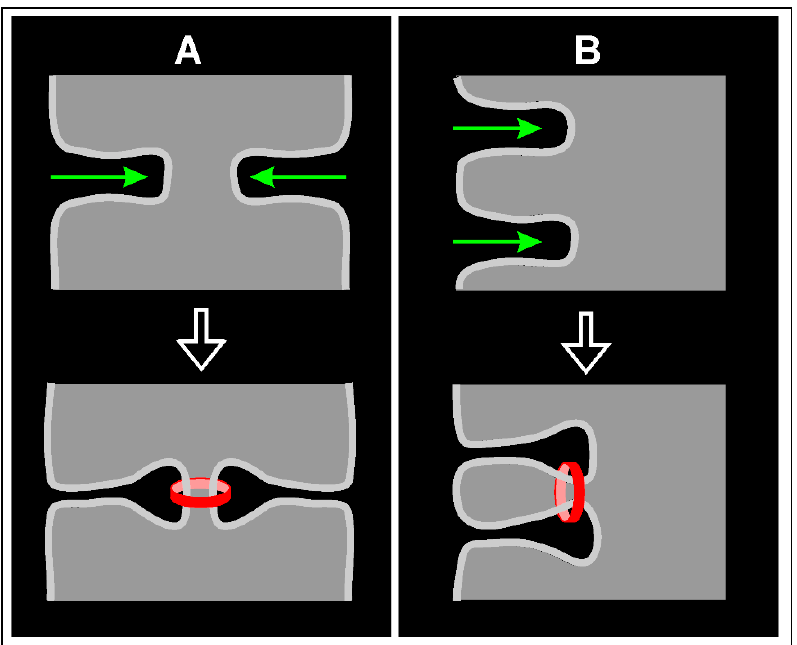
Figure 8. Diagram of cytokinesis in multinucleate cells, illustrating the variable spatial relationship of initial furrow ingression (green arrows) and final abscission (red ring). ( A ) Two furrows ingressing from opposite sides, and separation proceeding along the furrow directions. ( B ) Two furrows ingressing in parallel directions, and abscission occurring obliquely to these directions.